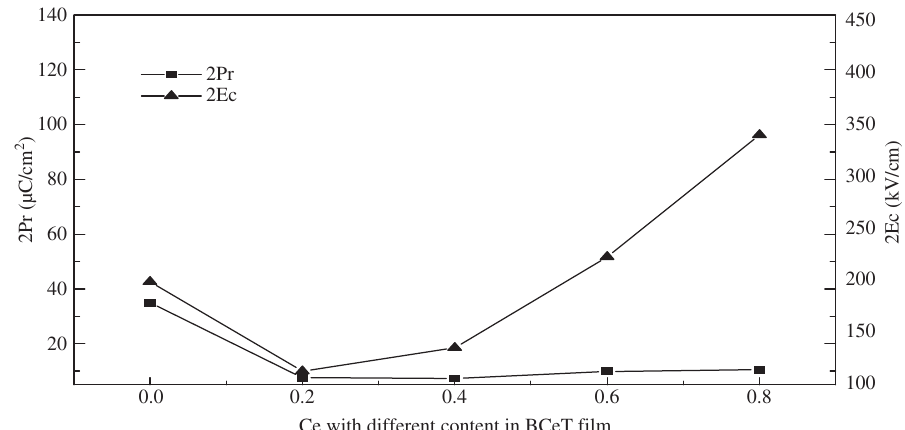
Figure 7 Pr and Ec of different Ce